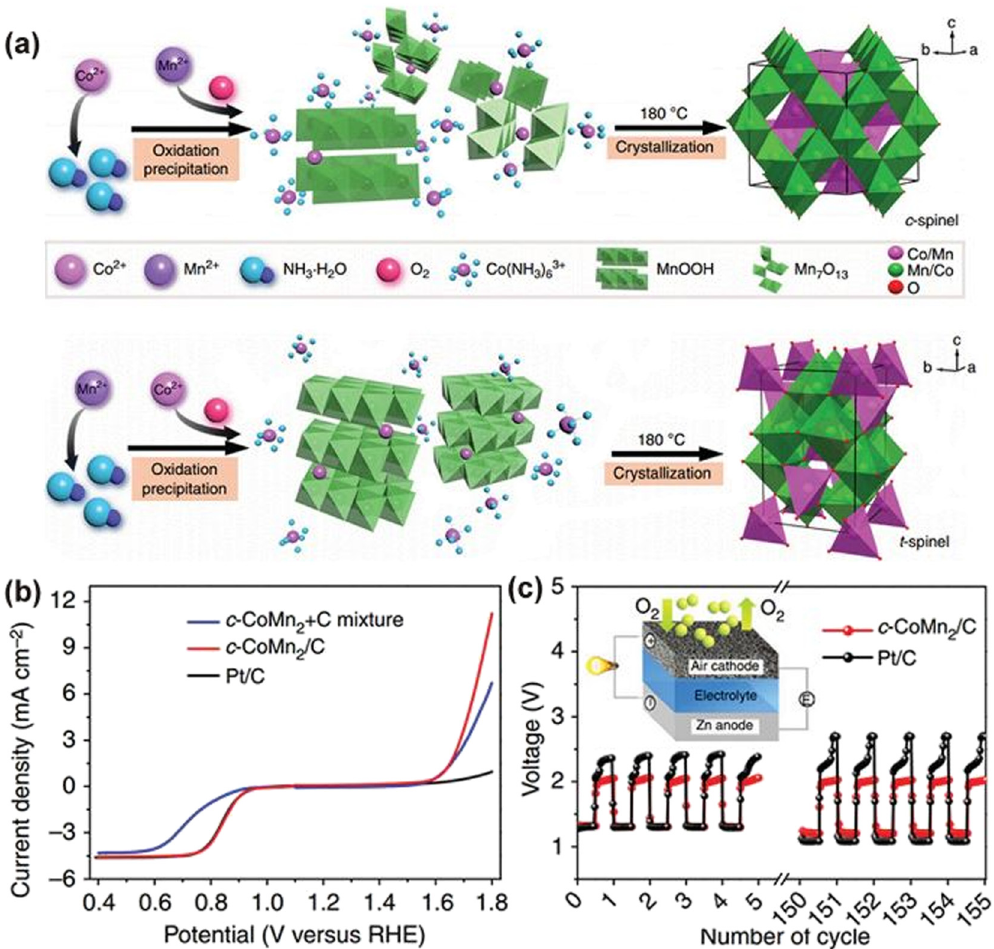
Figure 5: ( a ) Diagram of the fabrication of cubic ( I ) and tetragonal ( II ) spinel conditions in two phases: oxidation precipitation step and crystallization step respectively. ( b ) The ORR and OER performances of mixed c − CoMn 2 /C, c − CoMn 2 /C hybrid and Pt/C catalysts in basic solution ( 0.1 M KOH ) . ( c ) Catalytic activities of rechargeable Zn – air batteries applying c − CoMn 2 /C, and Pt/C as cathodic ORR electro - catalysts at a 10 mA cm − 2 looping rate and a period of 400 s per loop. The inset illustrates the framework of an amassed rechargeable Zn – air battery. Redrawn from [ 97 ] , copyright 2015, Nature Publishing